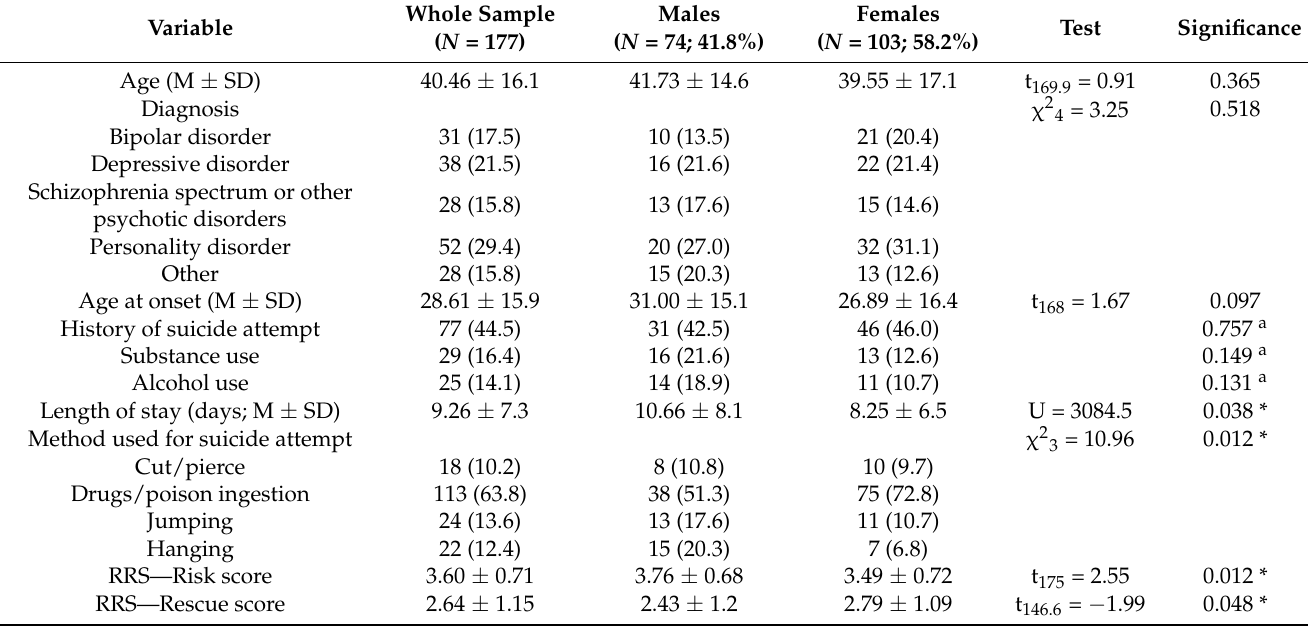
Table 1. Differences between